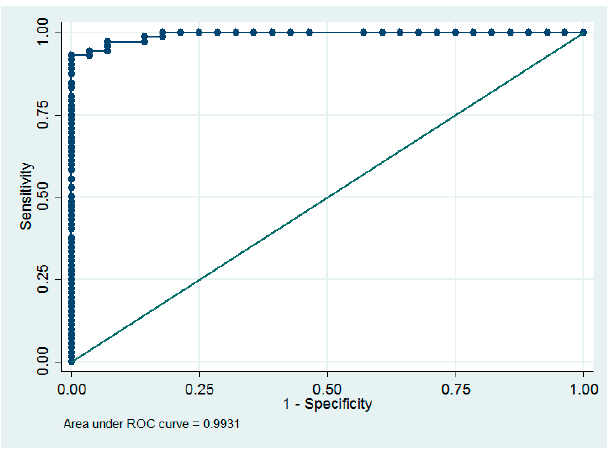
Figure 3. Receiver operating characteristic (ROC) curve for the dependence between maternal levels and optimal neonatal levels.